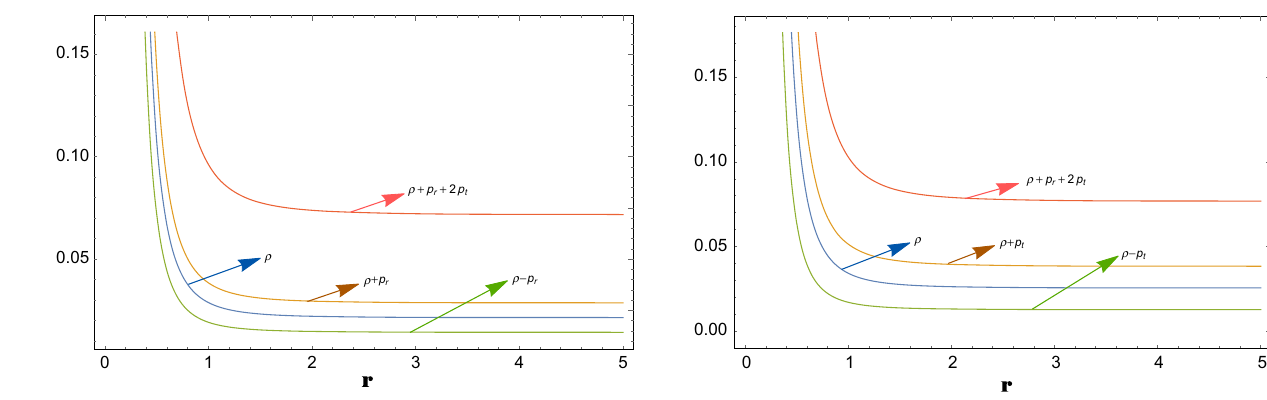
Fig. 3 Behaviour of the matter-energy density, NEC, DEC and SEC, with r 0 = 1 ,γ = 1, m = 0 . 5 and χ = 6, for model